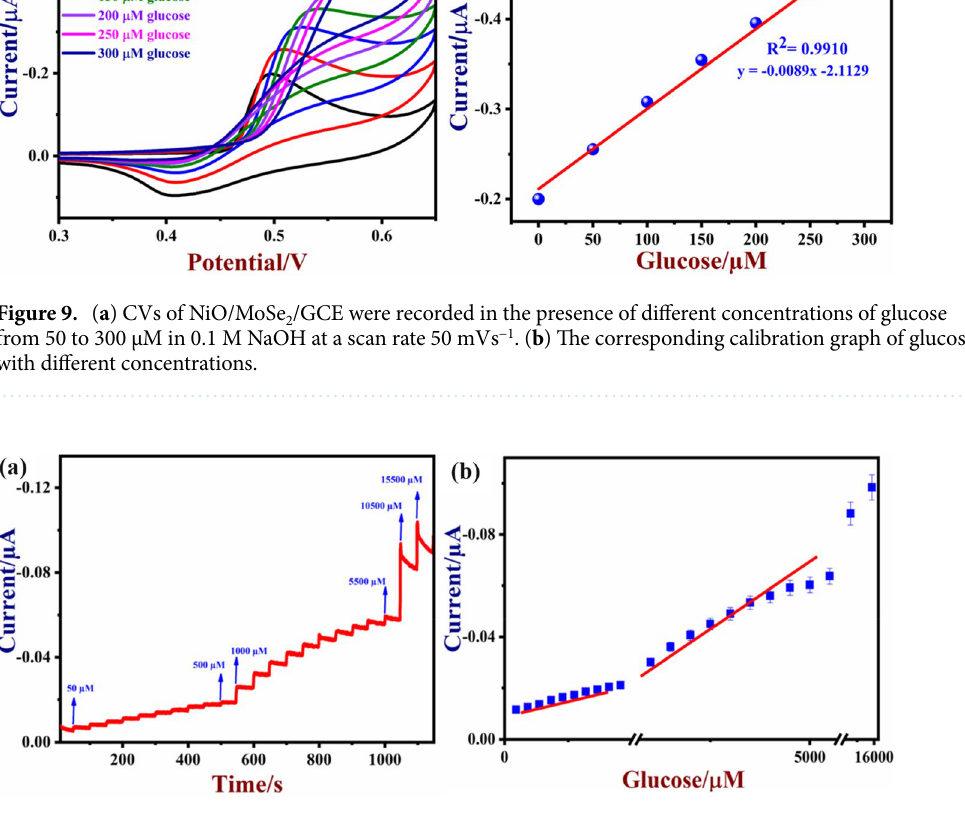
Figure 10. ( a ) Amperometric curve was recorded using a NiO/MoSe 2 /GCE with the successive additions of glucose from 50 µM to 15.5 mM at 0.5 V in 0.1 M NaOH. This solution was stirred at 1200 rpm. ( b ) The corresponding calibration plot of glucose with the standard deviation (n =